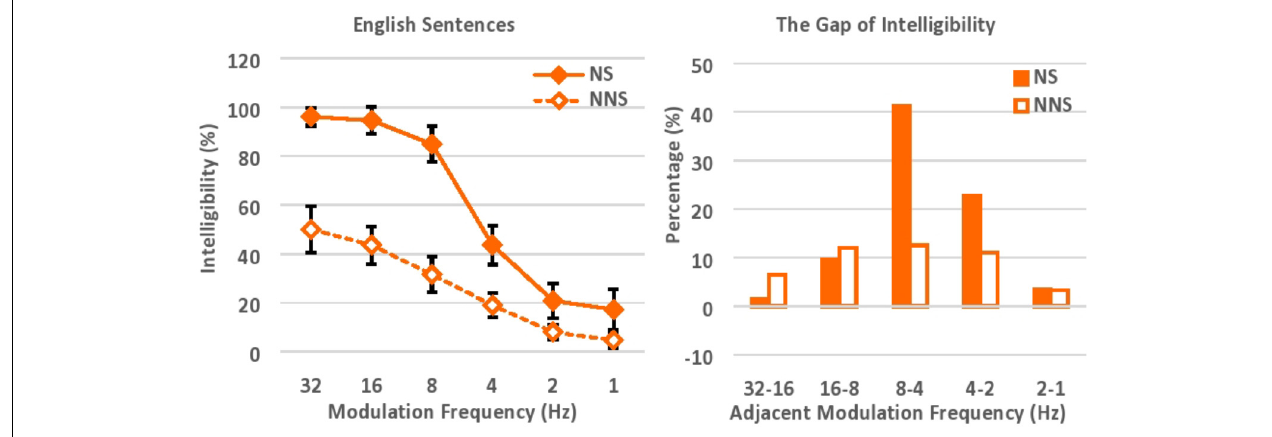
FIGURE 4 | Intelligibility of English sentences with various low-pass cut-off frequencies (left) , and the gap of intelligibility between adjacent cut-off frequencies (right) . NS, Native speakers of English; NNS, Non-native speakers of English (native Japanese speakers who speak English as a second